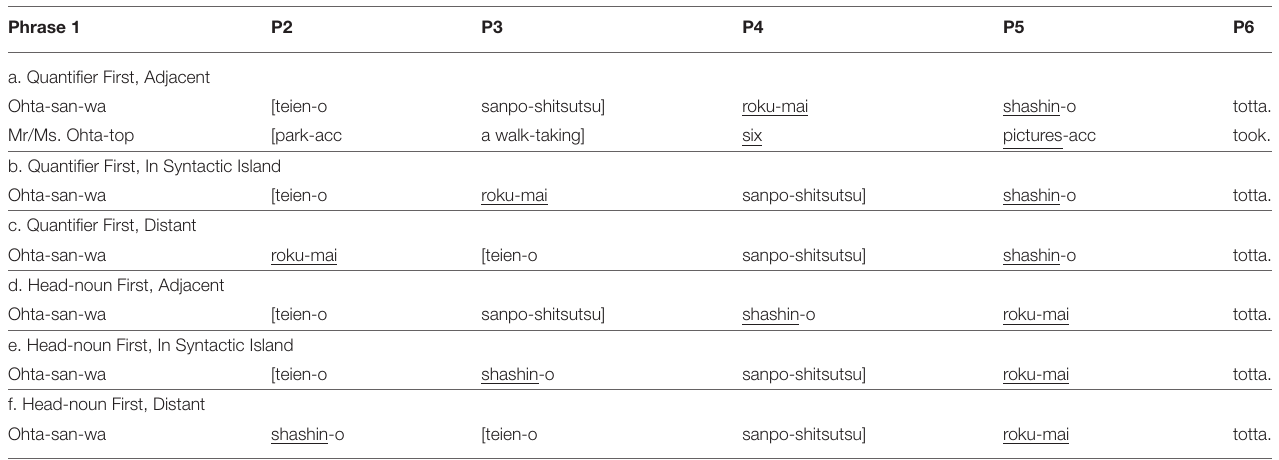
TABLE 1 | Examples of the experimental sentences. Phrase